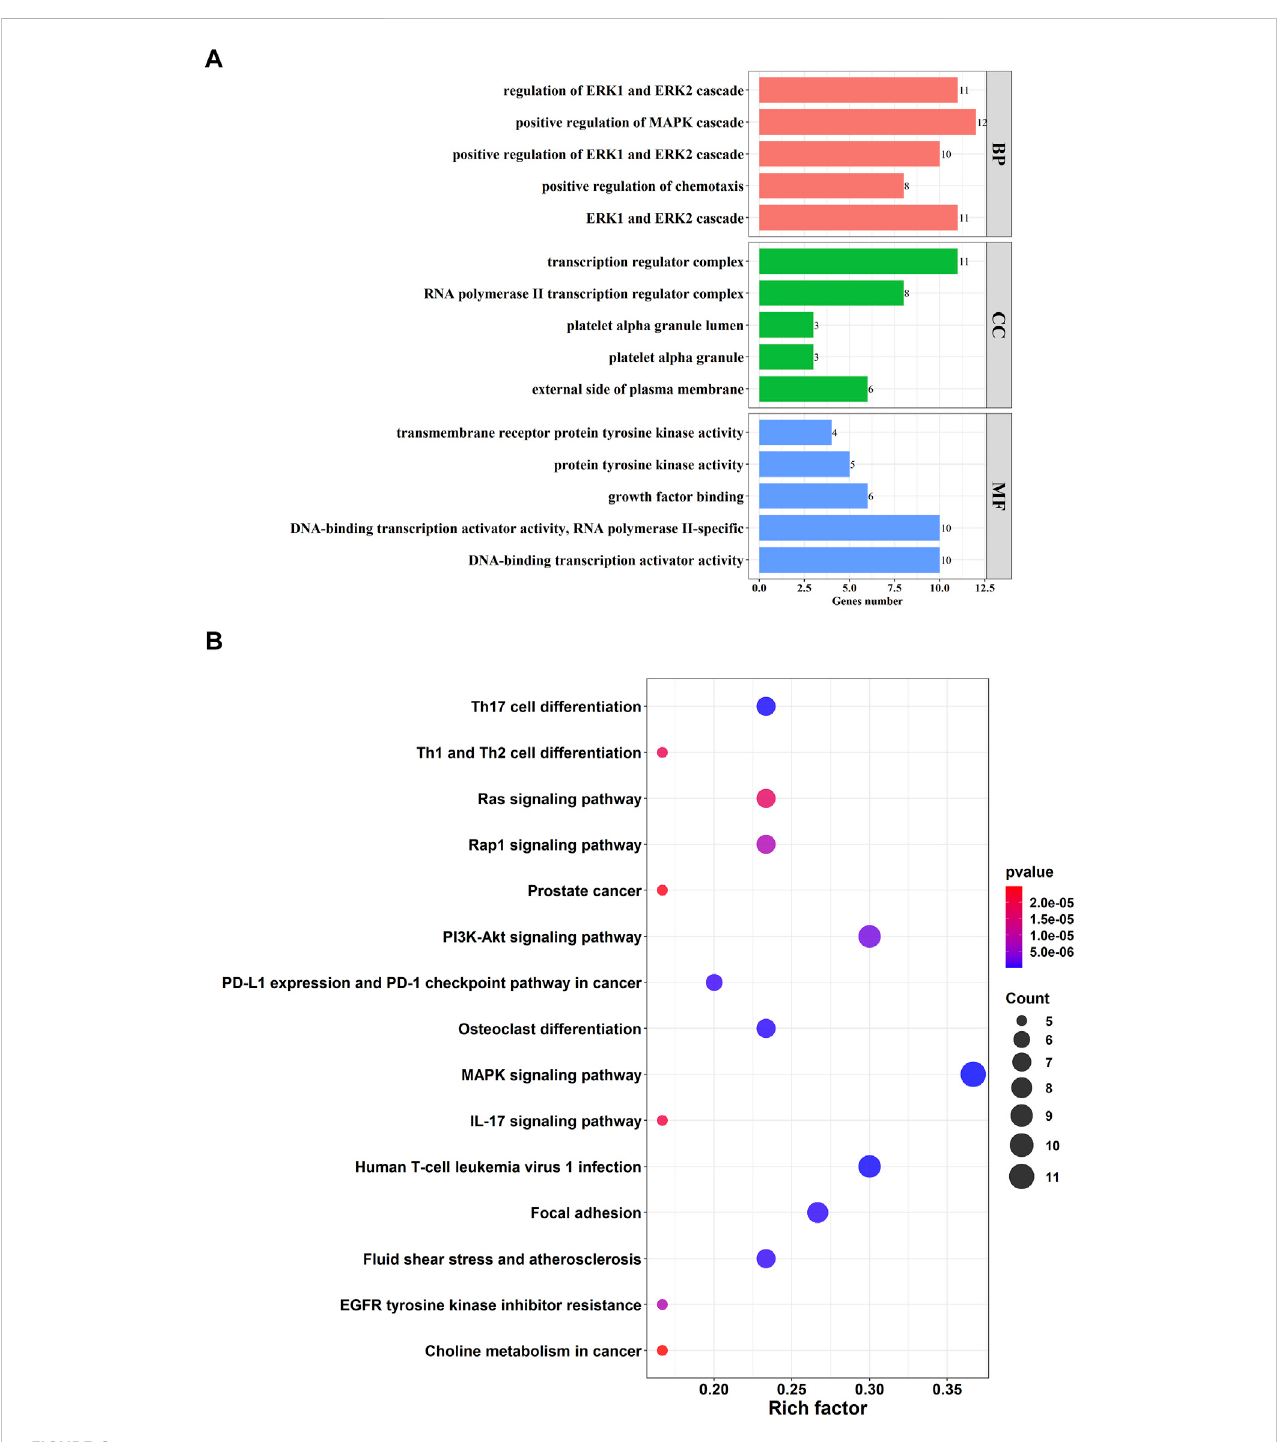
FIGURE 6 Function enrichment analysis of 17 key targets. (A) Top fi ve terms of Gene Ontology (GO) enrichment analysis. GO consists of biological processes (BP), cellular component (CC), molecular function (MF); (B) Top 15 pathways of Kyoto Encyclopedia of Genes and Genomes (KEGG) enrichment